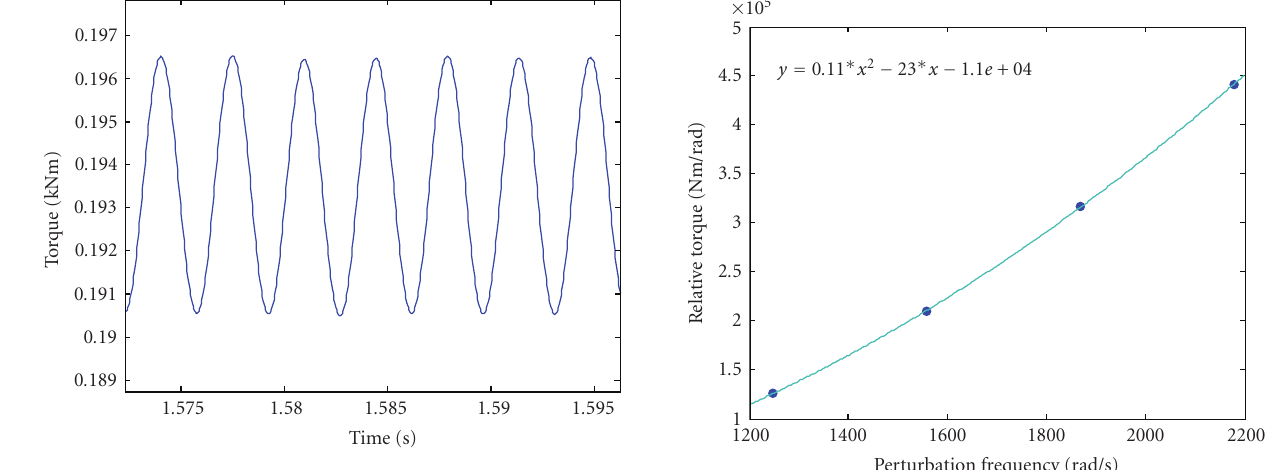
Figure 3: The torque as a function of time for one of the simulated cases (rotational speed is 72rad / s and the oscillating frequency is 1809rad / s).